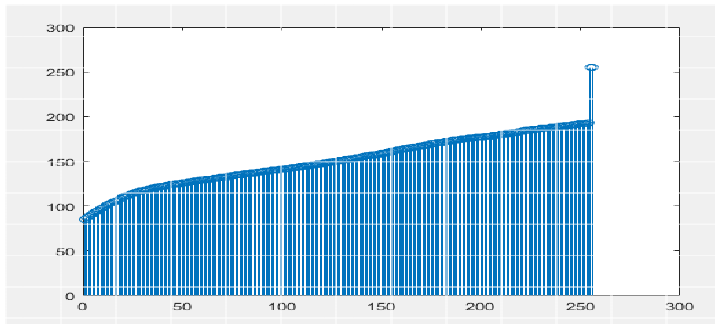
Figure 4. Preprocessing state of CT image by applying histogram